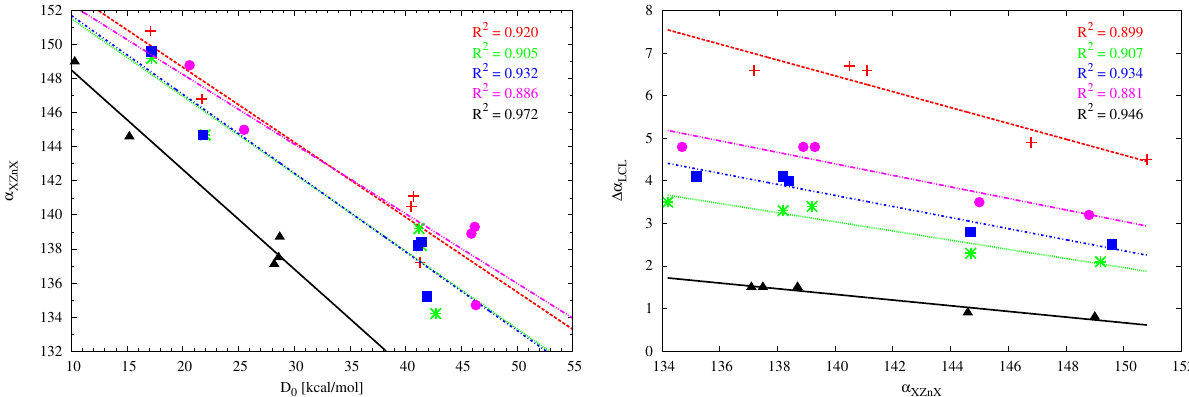
Figure 9. Relationships between either the XZnX angle ( α XZnX ) and the dissociation energy ( D 0 ) (left) or the change of the LCL angle ( ∆ α LCL ) and α XZnX (right) for the L 2 C · · · ZnX 2 dimers (where L 2 C = (NH 2 ) 2 C (red), imidazol-2-ylidene (green), imidazolidin-2-ylidene (blue), tetrahydropyrymid-2-ylidene (magenta), cyclopropenylidene